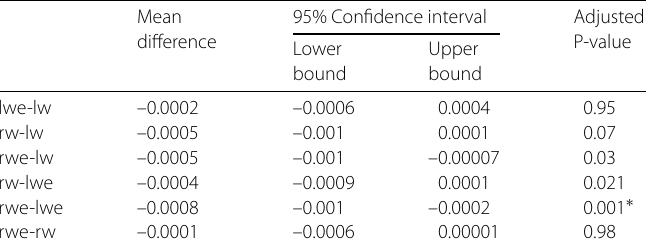
Mean 95% Confidence interval Adjusted difference